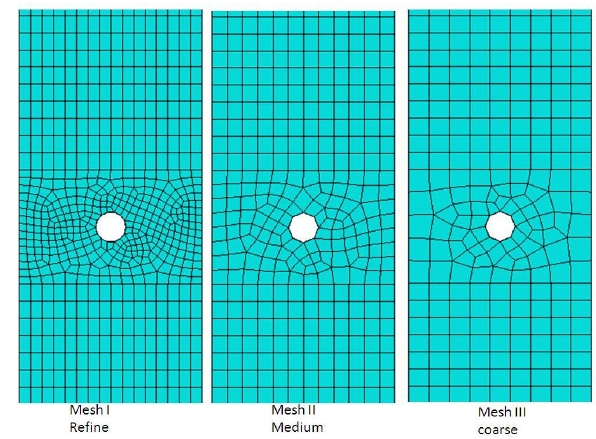
Fig. 3. Different FE mesh.